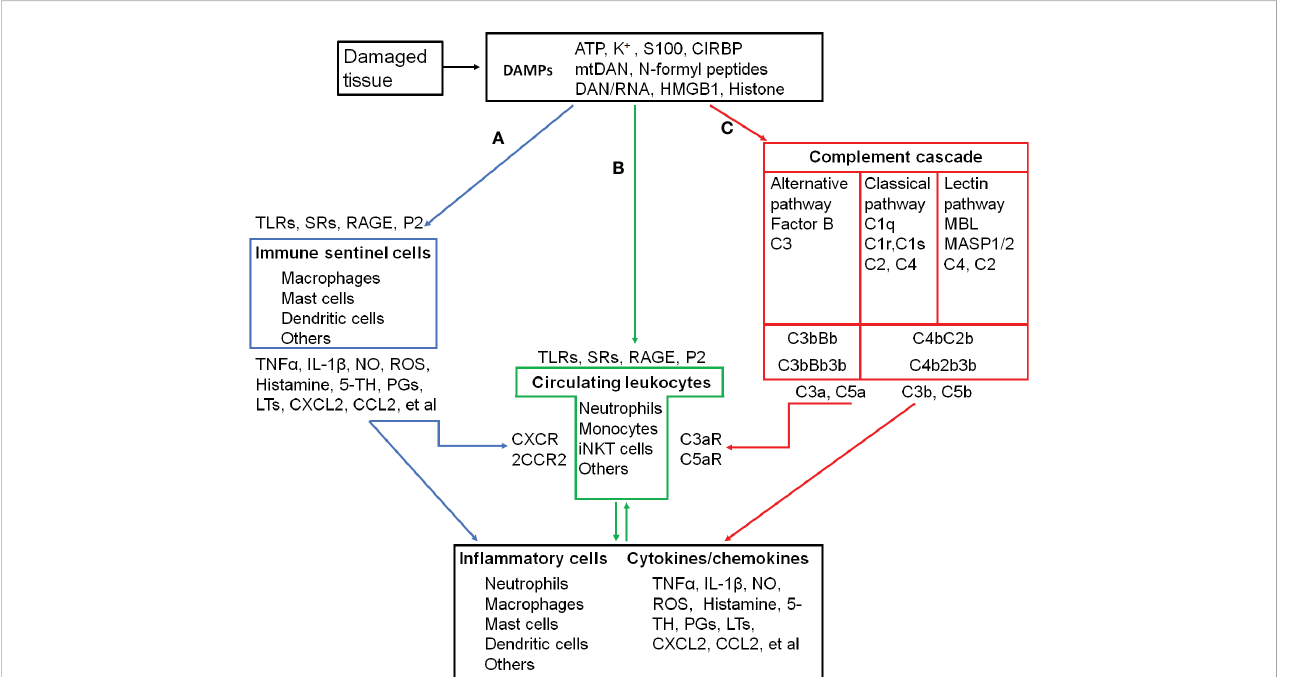
FIGURE 1 In fl ammatory activation and its triggers in the skeletal muscle. (A-C) , three pathways that activate in fl ammatory cells. (A) , proteolytic cascades of complements are triggered by the damaged tissue and released C3a and C5a recruit and activate circulating leukocytes. (B) , DAMPs released into circulation are recongnized by circulating leukocytes, which are recruted to and activated in the injured site. (C) , damaged tissue-activated local immune sentinel cells release cytokines and chemokines to recruit and activate circulating leukocytes. ATP, Adenosine triphospate; CCL2, C-C motif chemokine ligand 2/Monocyte chemoattractant protein-1 (MCP-1); CCR2, C-C motif chemokine receptor; CIRBP, Cold-inducible RNA-binding protein; CXCL2, C- X-C motif chemokine ligand 2/macrophage in fl ammatory protein 2-alpha (MIP2- a ); CXCR2, C-X-C motif chemokine receptor 2; DAMPs, Damage- associated molecular patterns; HMGB1, High mobility group box-1; IL-1 b , interleukin-1 b ; iNKT cells, Invariant natural killer T cells. LTs, Leukotrienes; MBL, Mannose-binding lectin; MASP1/2, MBL-associated serine protease-1/2; mtDNA, mitochodrial DNA; NO, Nitric oxide; PGs, Prostaglandins; P2, Purinergic preceptors (P2Rs); S100, S100 protein; RAGE, Receptor for advanced glycation endproducts; ROS, Reactive oxygen species; SRs, Scavenger receptors; 5- TH, Serotonin; TLRs, Toll-like receptors; TNF a , Tumor necrosis factor a ; C1 (2, 3, 4, 5), complement component 1 (2, 3, 4, 5); C1q, C1 complex componet – recognicition molecular C1q; C1r and C1s, C1 complex componet — tetrameric protease complex C1R 2 S 2 ; C3bBb and C4b2b, C3 convertase; C2b, smaller fragment of C2 cleaved by C1s; C3a and C3b, two fragments of cleaved C3; C4b, Complement component C4b; C4bC2b, C3 convertase; C3bBb3b and C4b2b3b, C5 convertase; C5a and C5b, two fragments of cleaved C5; C3aR, C3a receptor; C5aR, C5a receptor; Factor B, Complement factor B; Bb, Fragment of complement factor